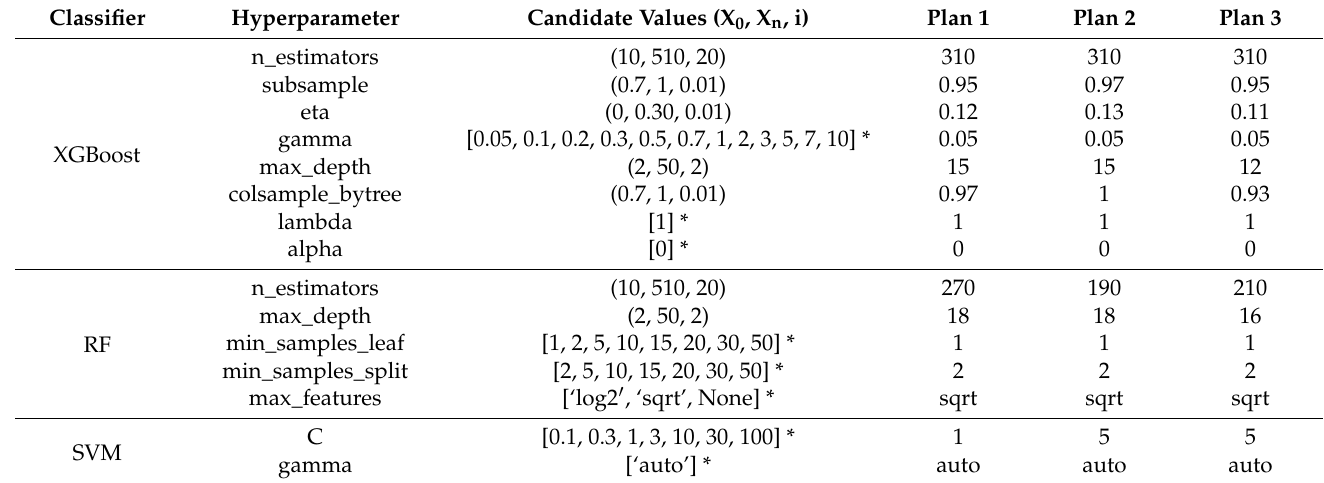
Table 4. Summarized data for hyperparameters for three machine learning classifiers.